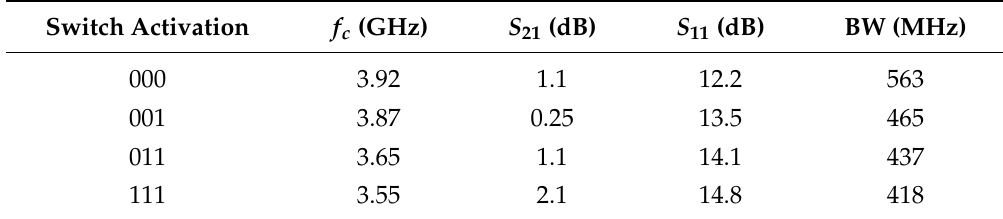
Figure 15. Simulated vs. measured scattering parameters of the pseudohairpin filter prototype: ( a ) return loss S 11 , ( b ) insertion loss S 21 . RF-MEMS switches configuration 001. Table 4. Summary of the measured results of the tunable pseudohairpin filter equipped with RF- MEMS